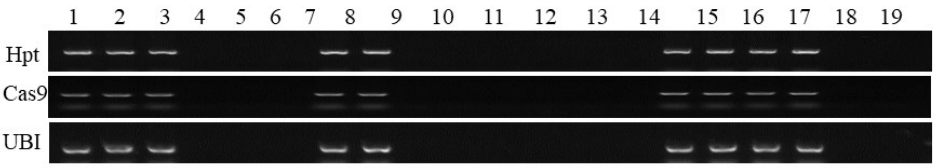
Figure 3. Molecular confirmation of T3 mutants. Note: Hpt (Hygromycin gene), Cas9 (Cas9 gene) and UBI (promotor sequence) are all located on the pREGB32 vector.1–19 were T3 generation plants, respectively. Primers in Supplementary Table S1.